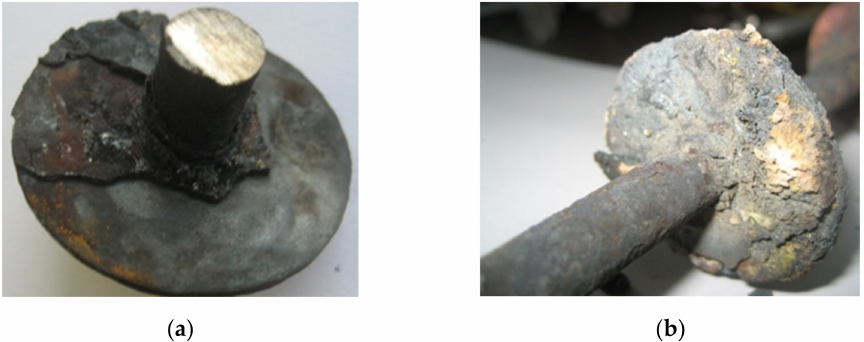
Figure 8. Photos of samples of the St41K boiler steel after exposure in the combustion chamber of the boiler: ( a ) a layer of porous corrosion products; ( b ) exposure of the substrate.